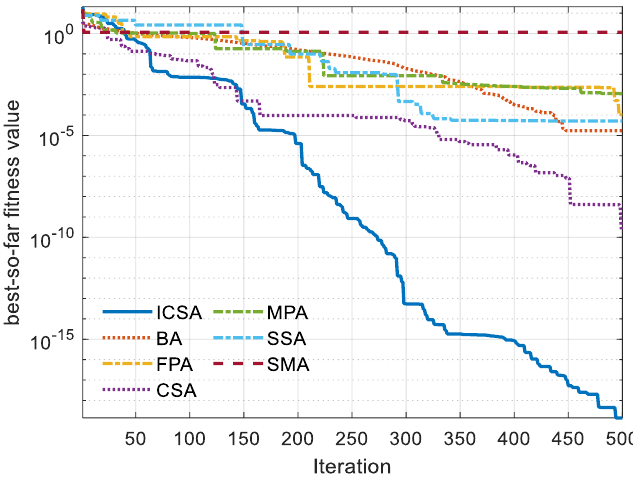
Figure 6. Convergence curve for F5.